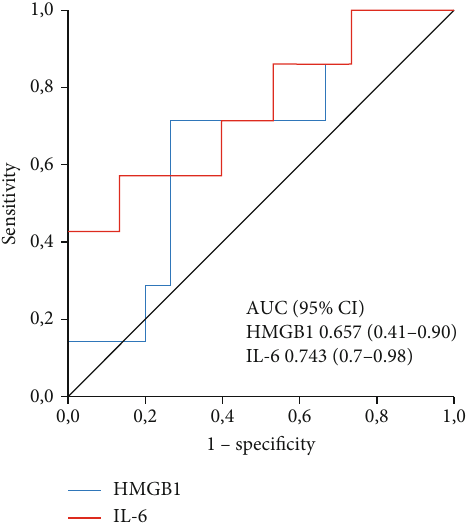
Figure 3: Receiver operator characteristic (ROC) curve and area under the curve (AUC) of HMGB1 and IL-6 in predicting three- month mortality. AUCHMGB1 = 0 : 657 (0.41 – 0.9); AUC IL ‐ 6 = 0 : 743 (0.7 –